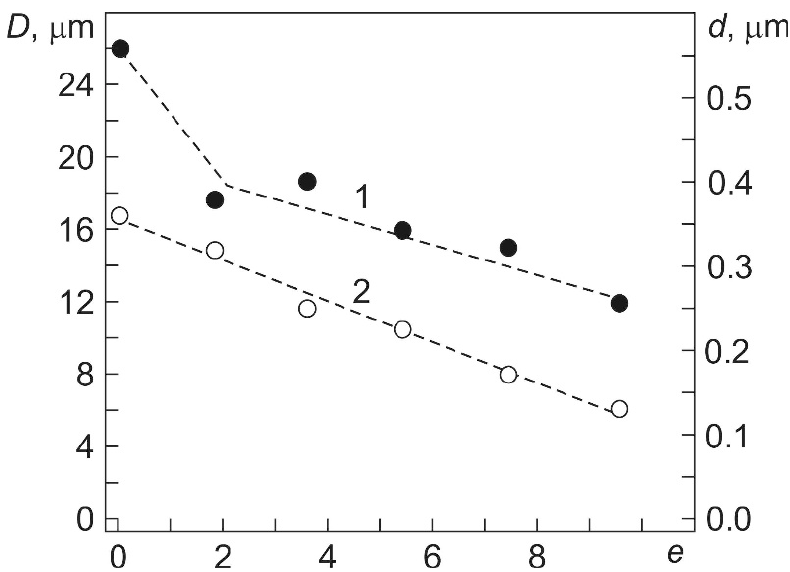
Figure 4. The average size of grains D (curve 1) and grain–subgrains d (curve 2) as the function of abc-strain, e .